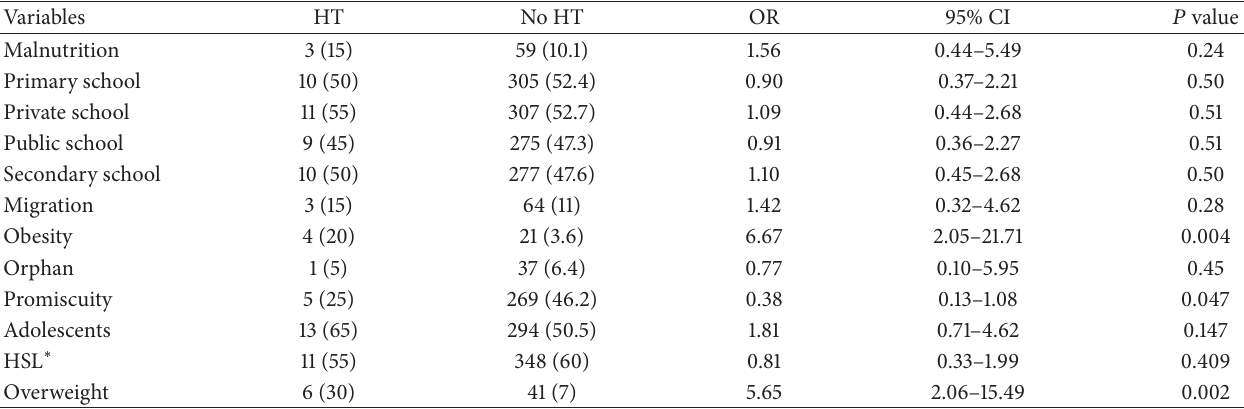
Table 5: Univariable odds of HT.